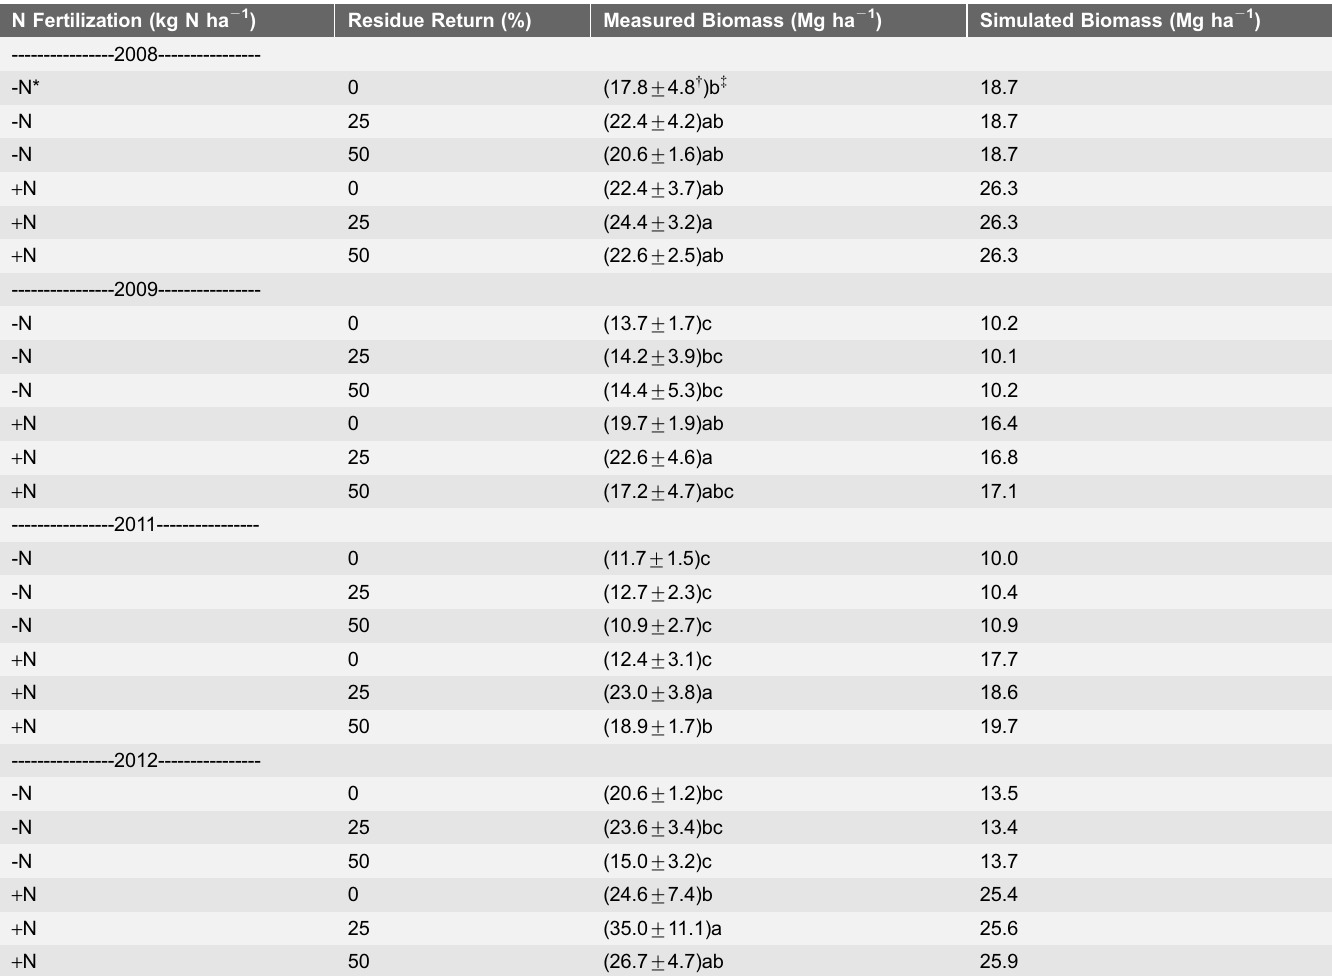
* -N and + N refer to without N fertilization and with a N rate at 300 kg N ha -1 for 2008 and 250 kg N ha 2 1 thereafter. { means with standard deviation. { Mean values within the same year labeled with different letters differ significantly at P ,